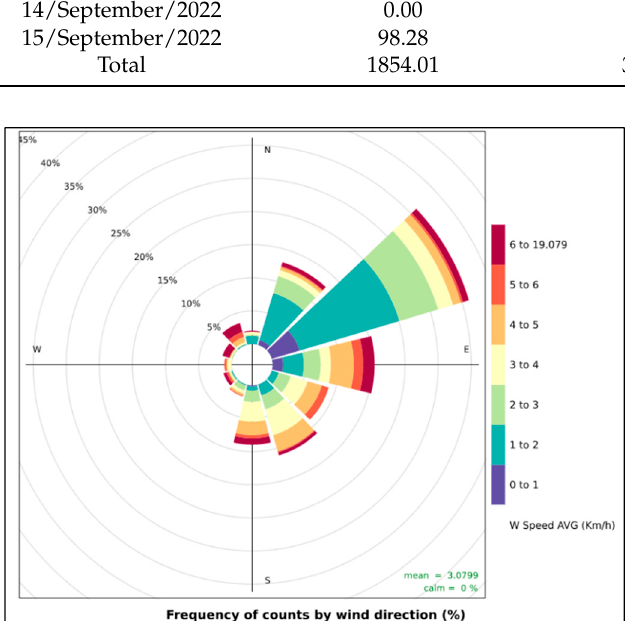
Figure 6. Average wind speed and direction at K2 measurement location over the experimental period 20 August–15 September 2022.